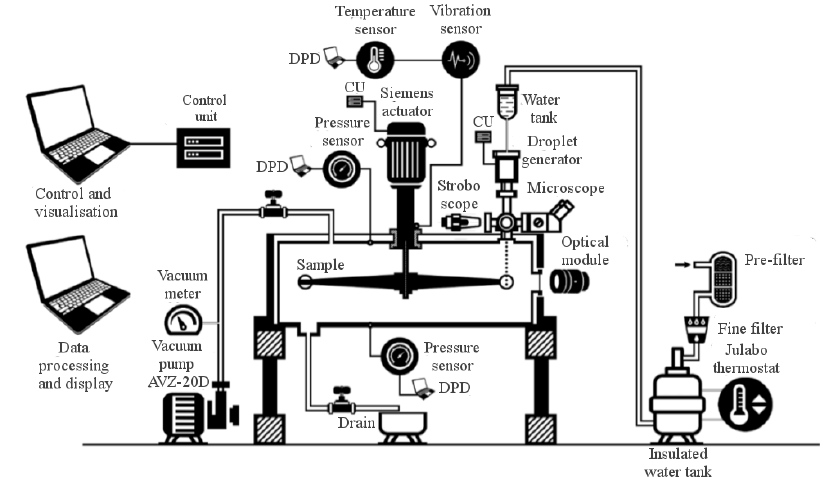
Figure 5. Diagram of hydro-impact test rig “Erosion-M”.